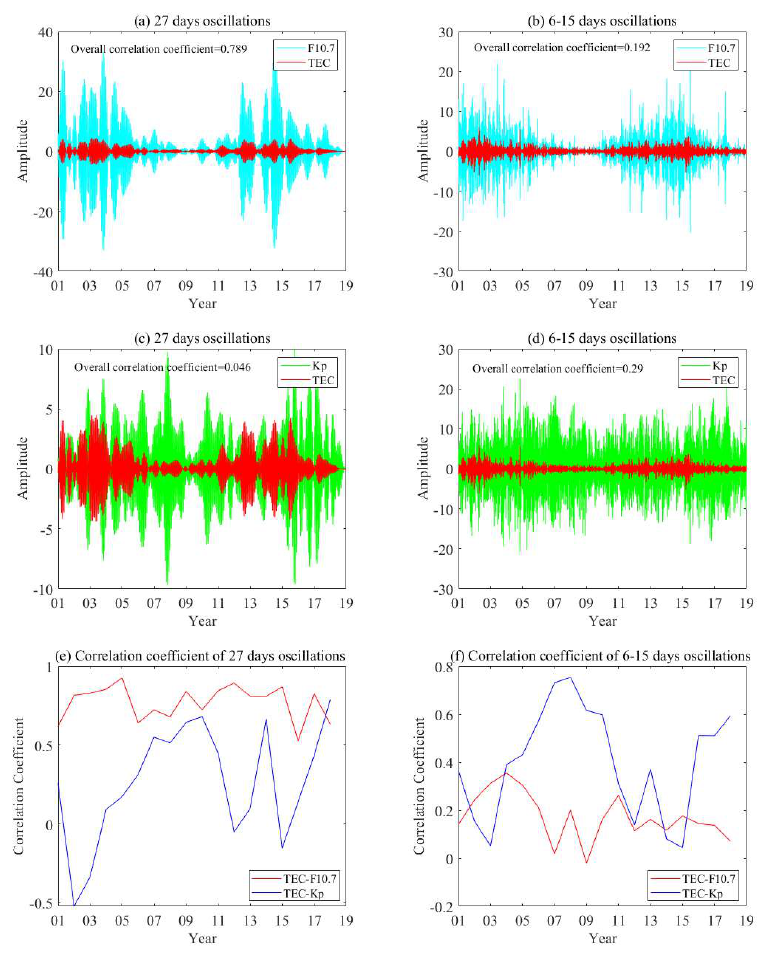
Figure 8. ( a , b ) The amplitude variations of the 27 (6-15)-day oscillations in TEC (red line) and F10.7 (blue line) during 2001–2018. ( c , d ) The amplitude variations of the 27 (6–15)-day oscillations in TEC (red line) and Kp (green line) during 2001–2018. ( e , f ) The comparison of the yearly correlation coefficient of the 27 (6–15)-day oscillations in TEC-F10.7 (red line) and TEC-Kp (blue line).